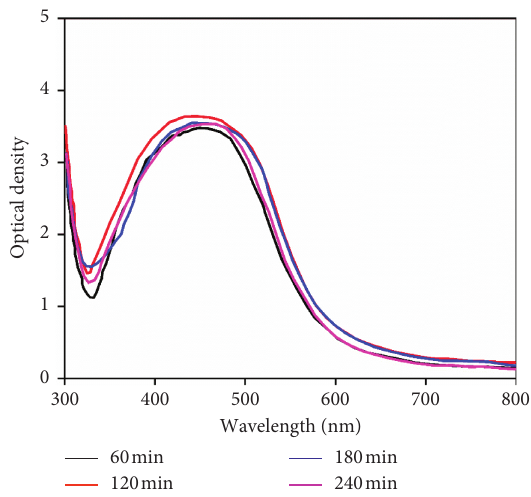
Figure 4: UV-vis absorption spectra of silver nanoparticles recorded as a function of reaction time of 0.01M AgNO 3 solution with leaf extract. Reaction temperature: 50 ° C; extraction volume: